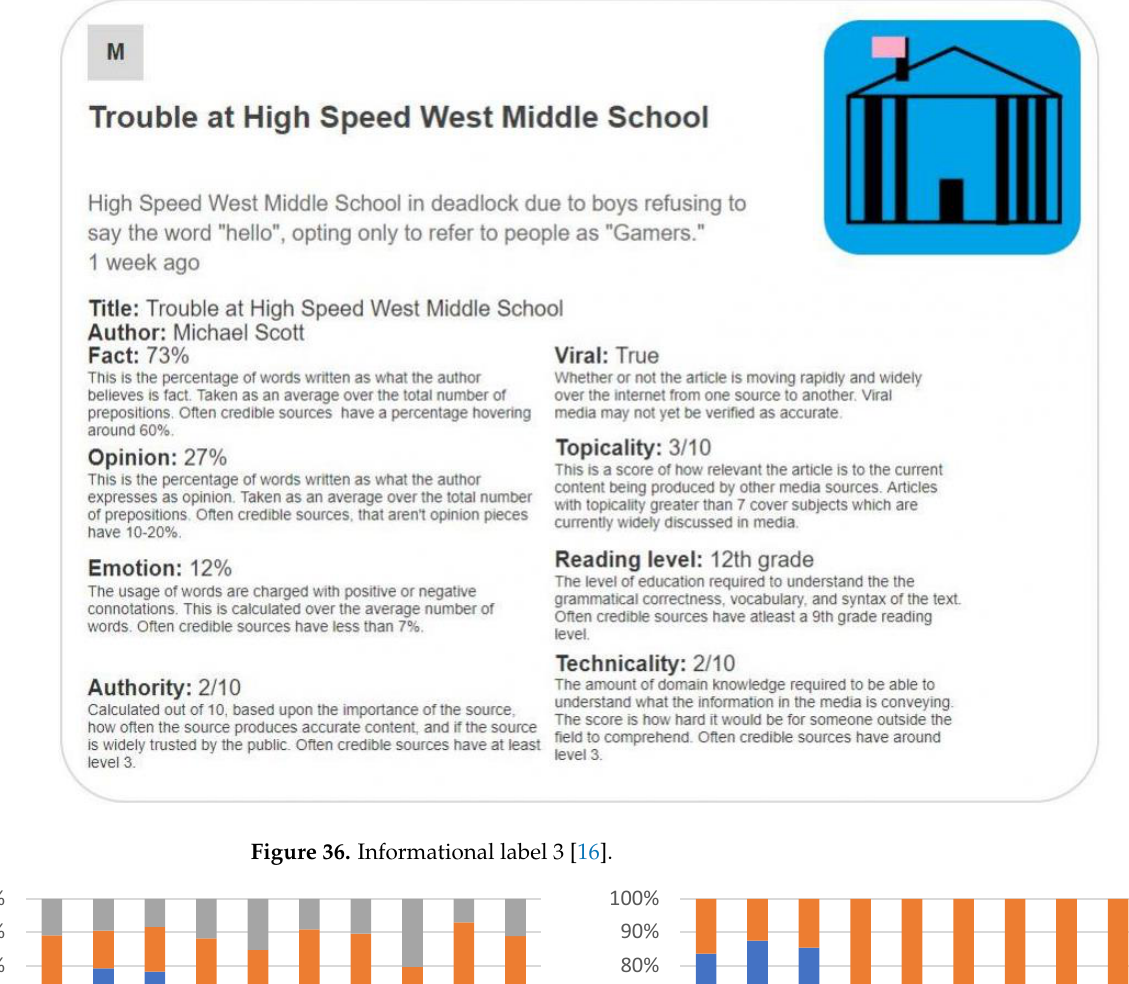
Figure 36. Informational label 3 [16].